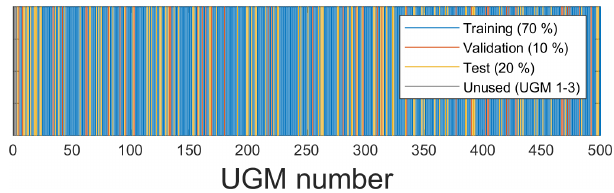
Figure 5. Randomized split of the UGMs into training, validation, and test data used in this